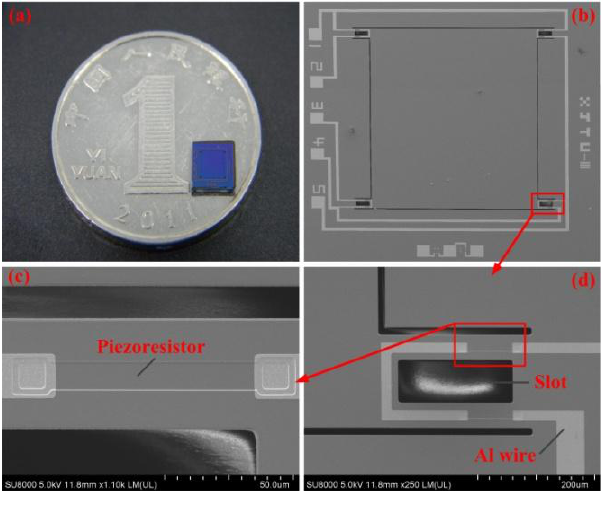
Figure 9. The fabricated sensor chip: ( a ) the sensor chip compared with a coin; ( b ) a photo of the whole chip; ( c ) a detailed SEM photo of one piezoresistor; ( d ) a detailed SEM photo of one slotted